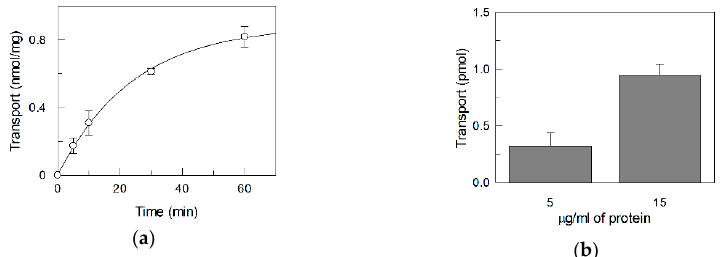
Figure 2. [ 3 H]Riboflavin uptake into proteoliposomes reconstituted whit recombinant hRFVT2. ( a ) The transport measurement was started adding 0.1 µM [ 3 H]riboflavin and stopped at the indicated times, as described in Materials and Methods. The values were corrected by subtracting the [ 3 H]riboflavin taken up by diffusion as described in Materials and Methods. ( b ) Riboflavin uptake in proteoliposomes measured in 60 min at two different protein concentration. The values are means ± S.D. from three experiments.